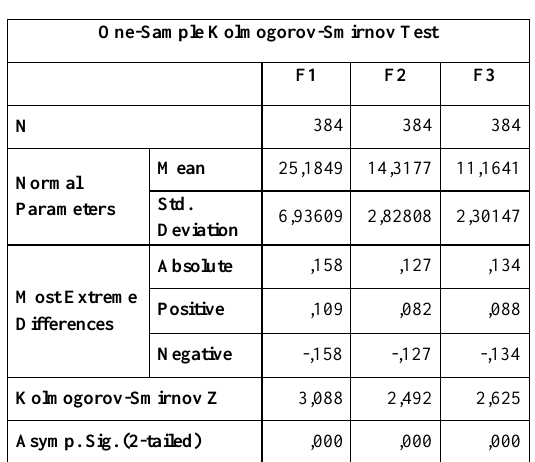
5: Kolmogorov-Smirnov Test Results Regarding the Sub-dimensions of the Scale of Consumer Perception on Guerrilla Marketing Methods (SCPGMM)